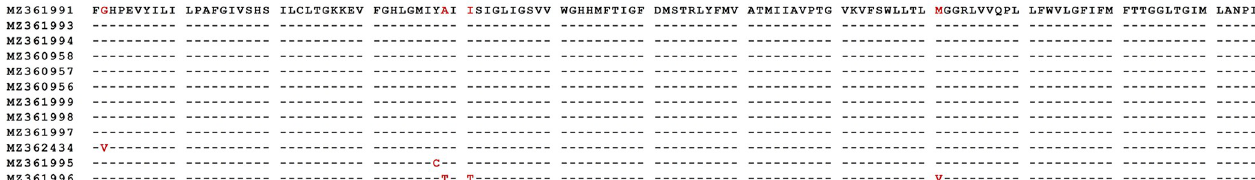
Fig 4. The amino acid alignment of mitochondrial cytochrome c oxidase 1 ( cox 1) gene of Iranian E . vermicularis haplotypes with marked changes in the amino acids sequence. Dots denote identical amino acids to the top sequence.